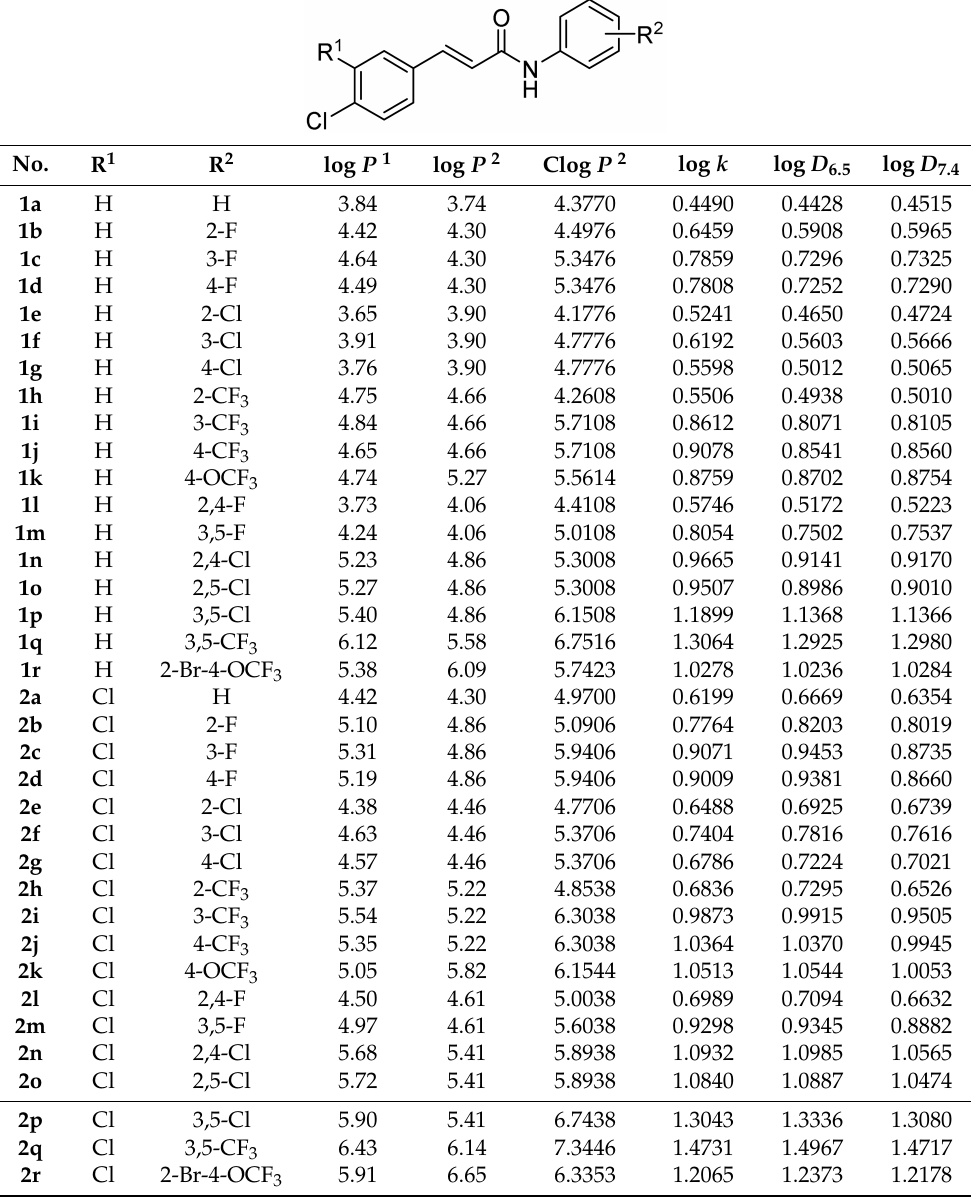
Table 1. Structures of ring-substituted (2 E )-3-(4-chlorophenyl)- N -arylprop-2-enanilides 1a – 1r , (2 E )-3- (3,4-dichlorophenyl)- N -arylprop-2-enanilides 2a – 2r , calculated lipophilicities (log P /Clog P ), and experimentally determined log k , log D 6.5 and log D 7.4 values of investigated